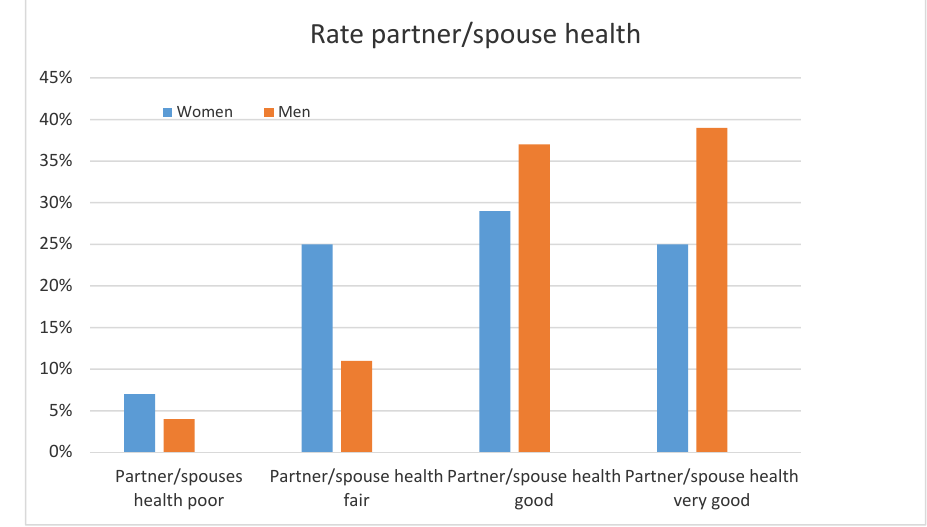
Figure 5. Rating partner’s health.